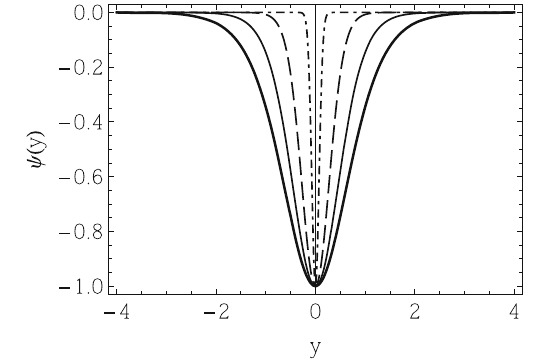
Fig. 17 Warp factor e 2 A given by Eq. (41) for c = 0 (thick solid line), c = 0 . 2 (thin solid line) and c = 0 . 4 (dashed